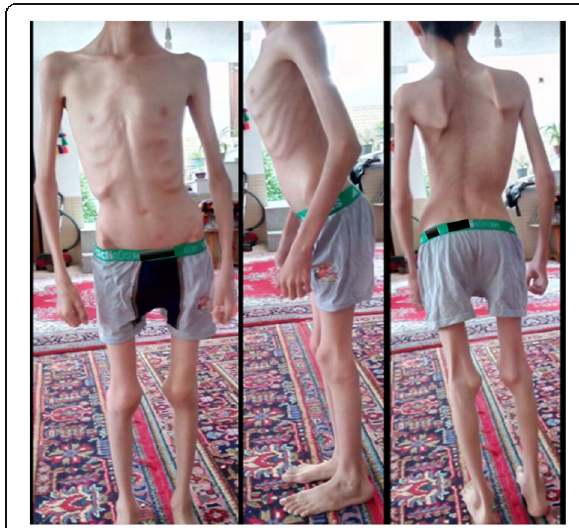
Fig. 1 Generalized muscular atrophy, kyphoscoliosis, and flexion contracture of the knees and elbows in our